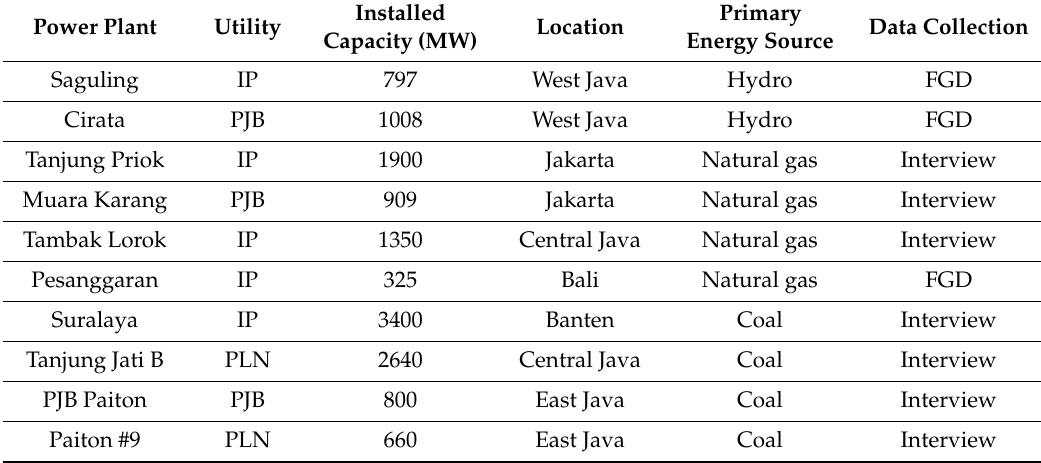
Table 2. Indonesian power plants where primary data collection has taken place.